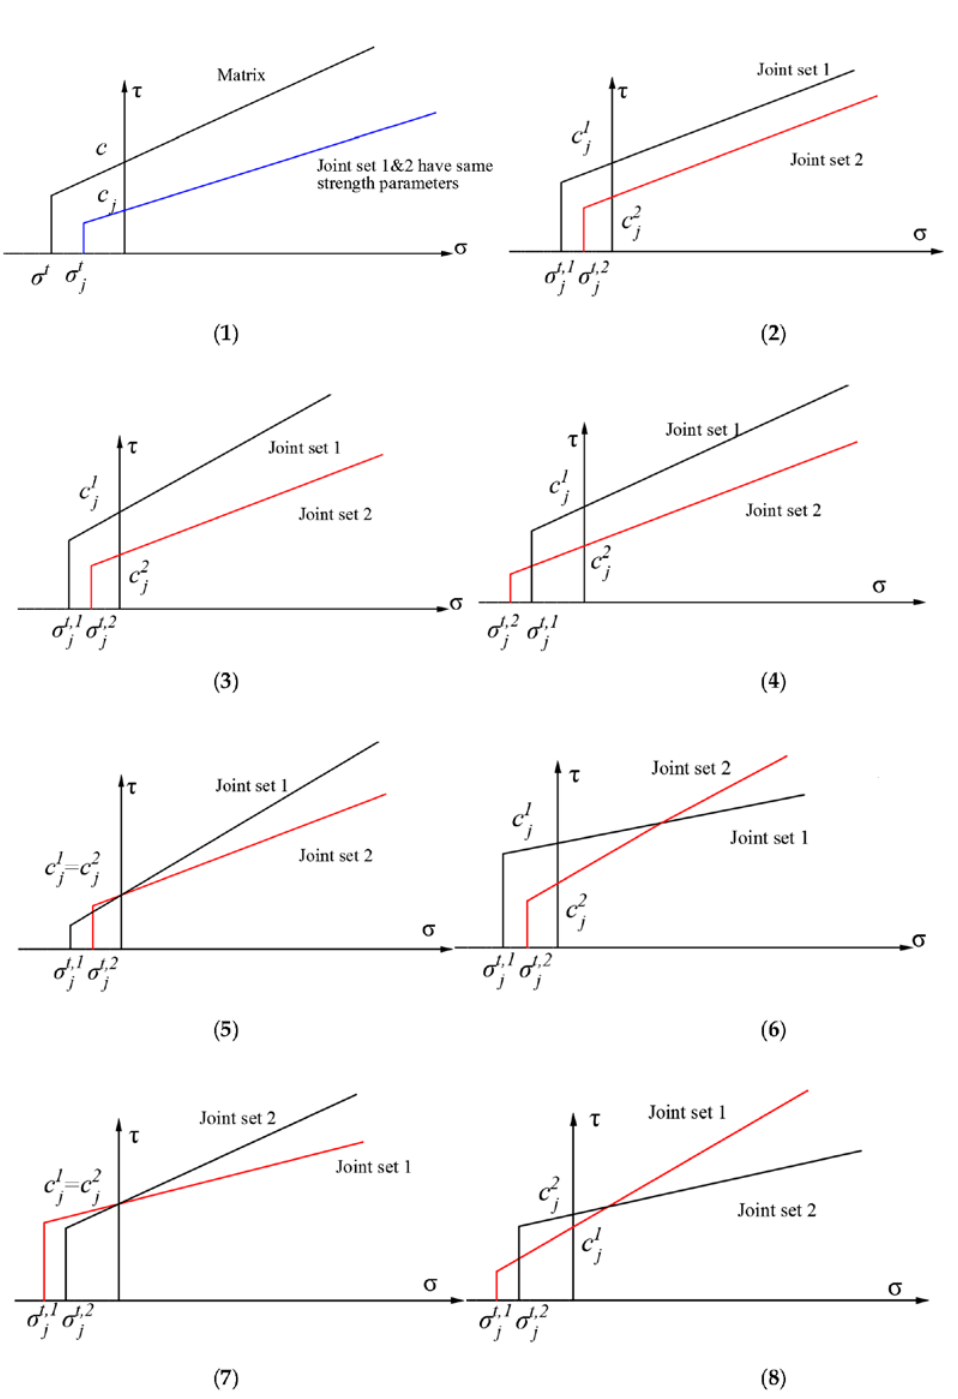
Figure 8. Sketch of potential failure envelops for two joints sets corresponding to the constellations 1–8 in Table 1. in Table